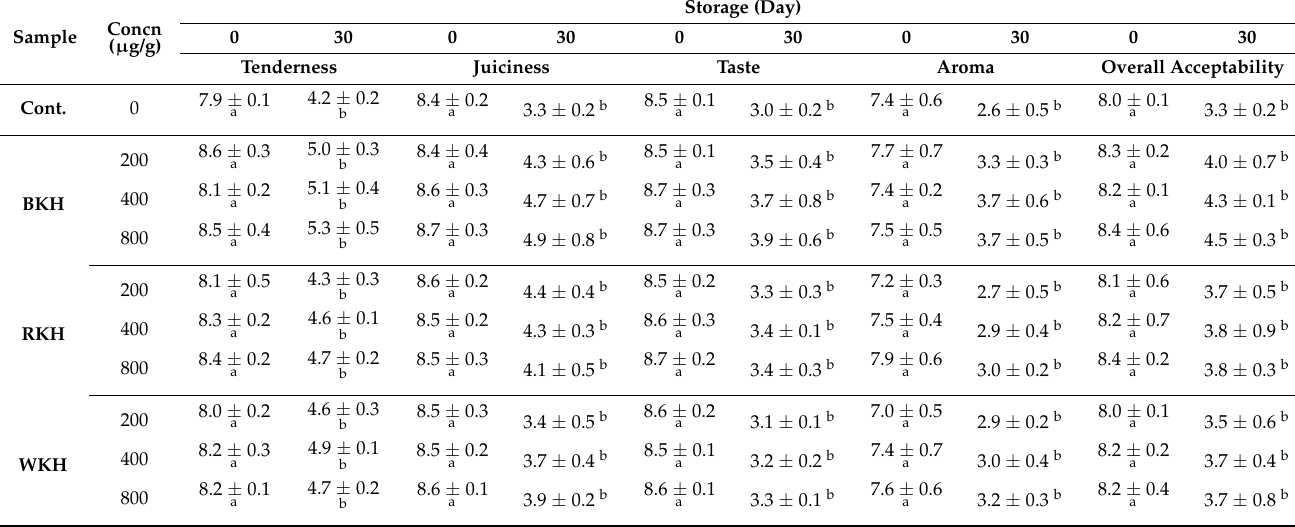
Cont.: control. All values are expressed as the means ± SD. Means with different lowercase letters in the same column indicate significant differences at p ≤ 0.05 by